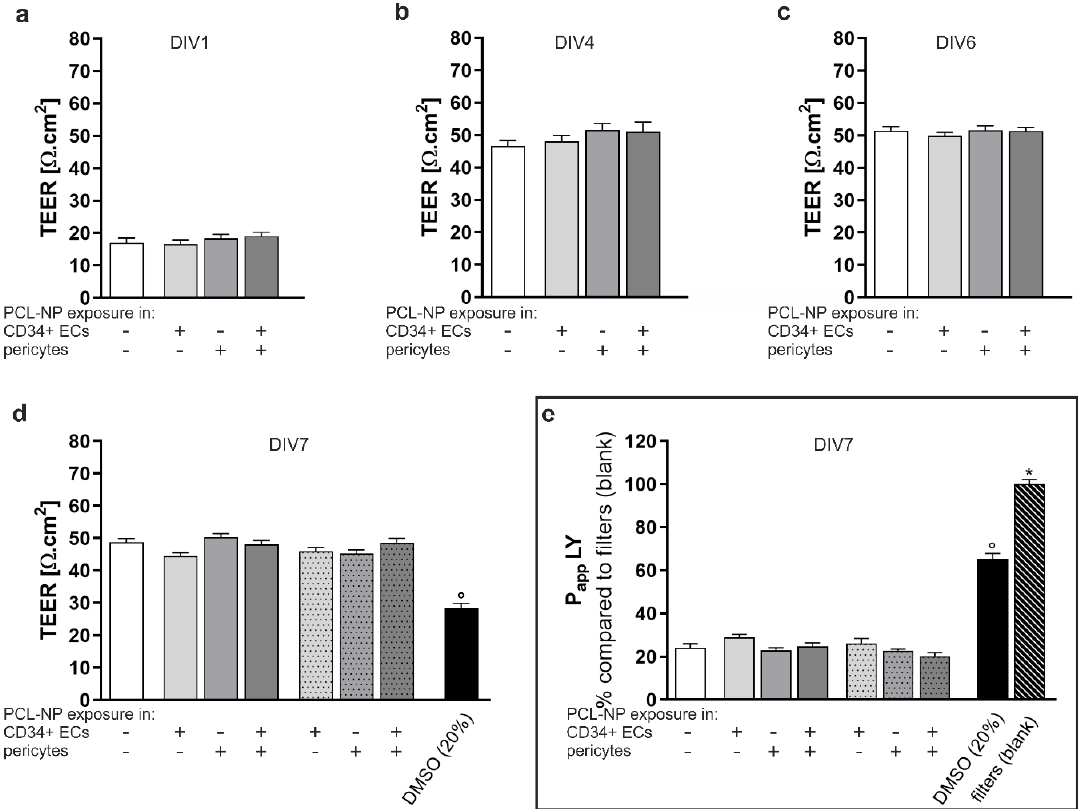
Figure 7. Effects of PCL-NPs on barrier formation of the hBLEC monolayer. Analyzes were performed by measurements of transendothelial electrical resistance (TEER) and the permeability to Lucifer yellow (LY); given as the apparent permeability coefficient P app ). CD34 + ECs TEER was measured every day of the co-culture; results are depicted for DIV1 ( a ), DIV4 ( b ), DIV6 ( c ) and DIV7 ( d ). CD34 + ECs or pericytes were exposed (+) to PCL-NPs for 2 h on day in vitro (= DIV) 1 (uniform filled bars), before establishment of the co-culture. hBLECs and pericytes were exposed (+) to PCL-NPs for 2 h on DIV7 (dotted bars). Non-exposed cells (-) were used as a control (Co) (white bars) ( n = 3). Stimulation with 20% ( v/v ) DMSO for 1 h on DIV7 was included as positive control (black bars). The permeability to LY was assessed on DIV7 ( e ). Concentration of PCL-NPs was (24.9 µ g/mL). Error bars represent SEM. Significant differences compared to the positive control or blank (striped filled bar) are labeled with circles ( ◦ ) or asterisks (*), respectively ( ◦ /* = p ≤